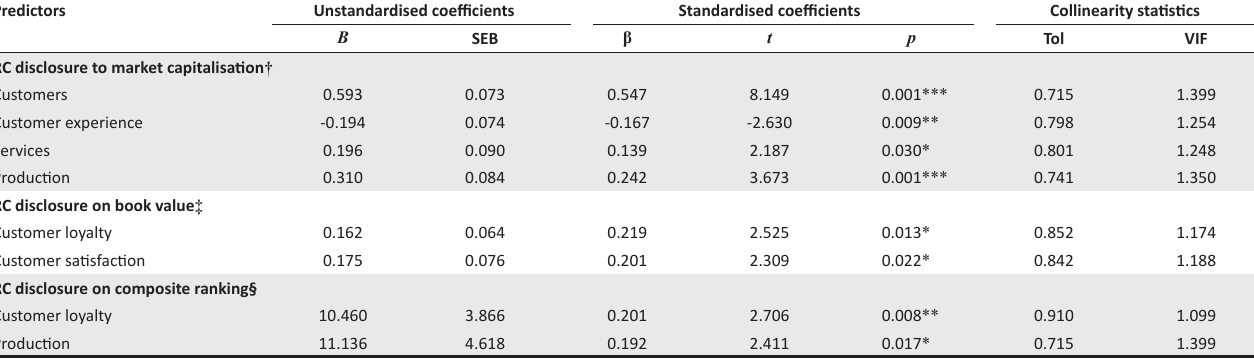
TABLE 6: Multiple regression of relational capital and organisational performance ( N = 150).